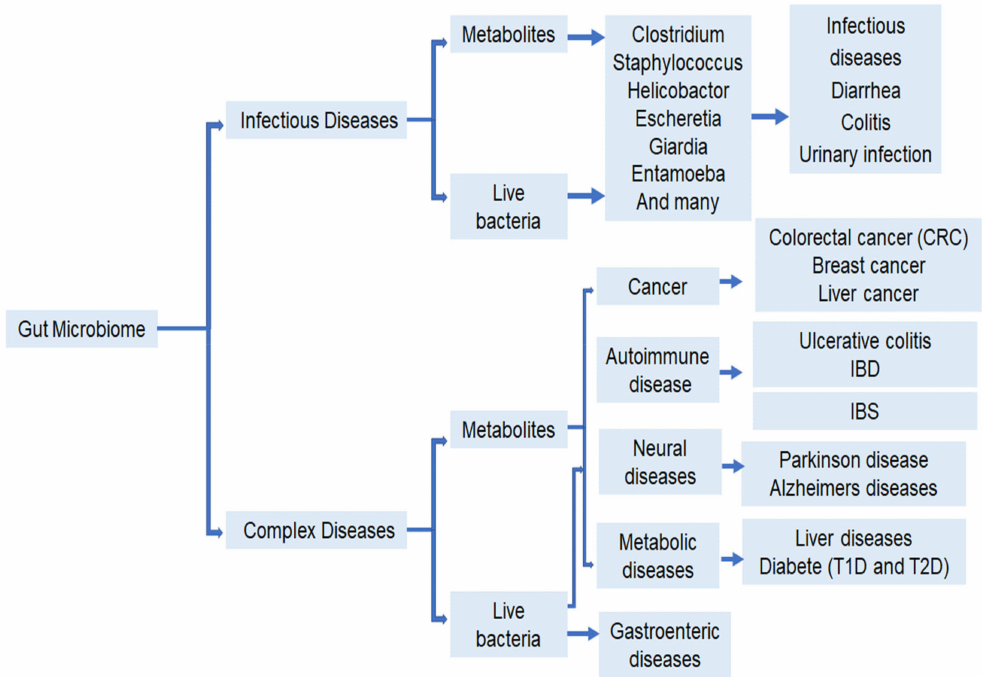
Figure 2. Gut microbiome in health and diseases. Gut microbes have impacts on both infectious diseases and complex diseases. Their metabolites can be directly involved to induce disease symptoms, for examples, diarrhea, colitis, etc. Although the gut microbiome may not directly induce complex diseases, such as CRC, autoimmune diseases and neuronal diseases, etc., they have profound effects on disease symptoms. As complex diseases occur due to interaction of genetic and environmental factors, gut microbes and their metabolites could play important roles as environmental factors and to help in shaping or reducing these symptoms. However, antibiotics affect the microbial population and have an overall adverse effect on human